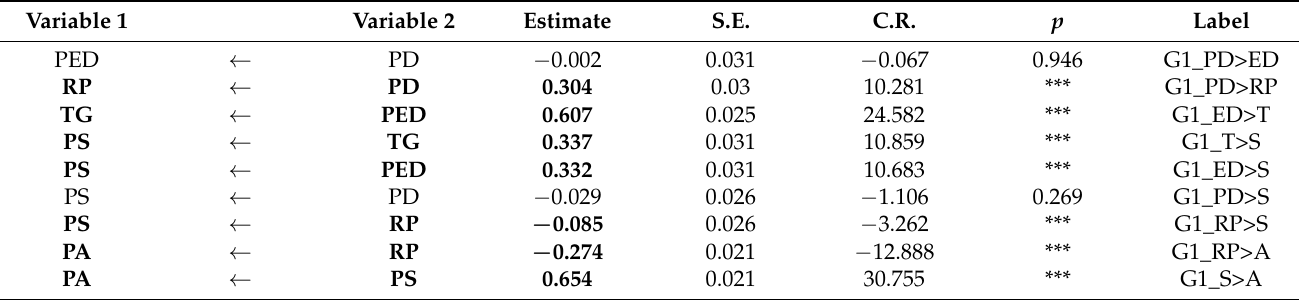
Figure 2. Validated research model (Note: * p < 0.05, ** p < 0.01, *** p < 0.001). Table 4. Results of path